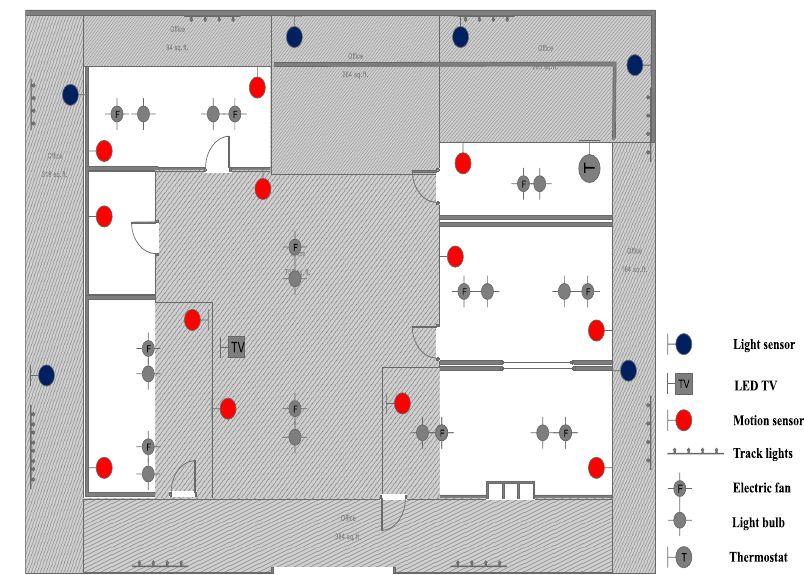
Figure 1. Conceptual diagram of tc and ua